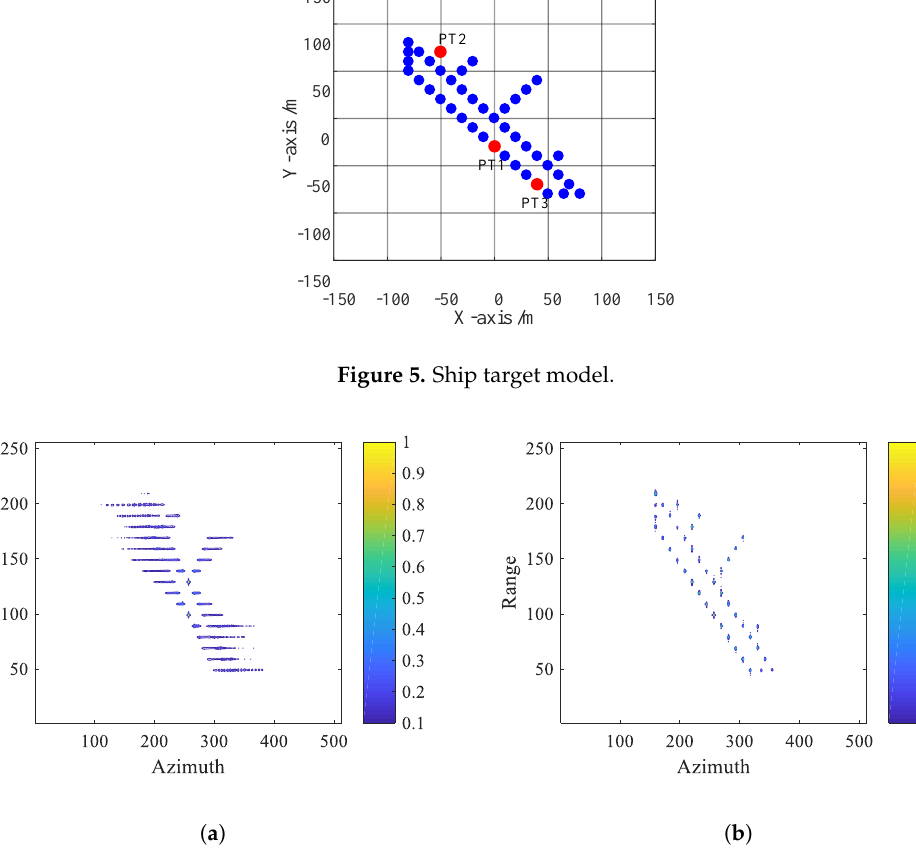
Figure 6. Ship images. ( a ) Ship image based on ISAR algorithm. ( b ) Refocused ship image based on